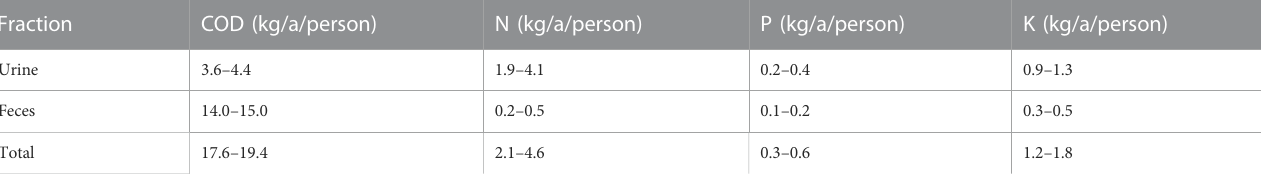
TABLE 1 Calculated estimation of the yearly nutrients in urine and feces (source: Larsen et al., 2016; Malila et al., 2019; Otterpohl, 2002; Stintzing and Salomon, 2004). Fraction